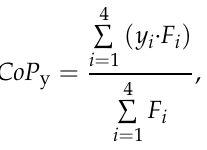
Figure 5. Calibration results of L / R crutches and L / R soles. ( a ) Calibration results of L / R crutches. F ZL and F ZR denote vertical components of L / R crutch endpoint GRF, respectively, and F N is the calculated vertical components of GRF based on measured palm and forearm pressure. ( b ) Calibration results of L / R soles. F LS and F RS are L / R gravities loaded on the soles, respectively. F SUML and F SUMR are the sum of gravities measured by 7 FSR sensors on L / R soles, respectively.